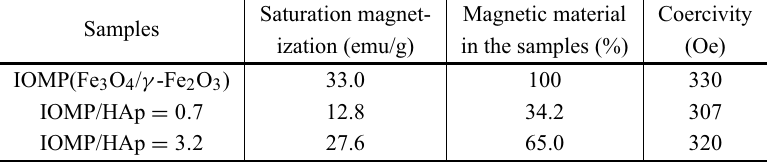
Magnetic properties of iron oxide particles and hydroxyapatite coated samples. Saturation magnet- Magnetic material Samples